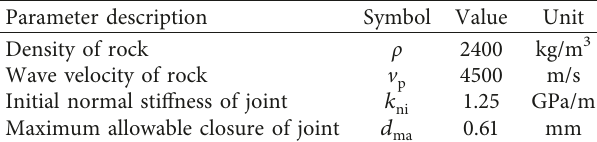
Table 1: Key parameters of a jointed rock mass [19].